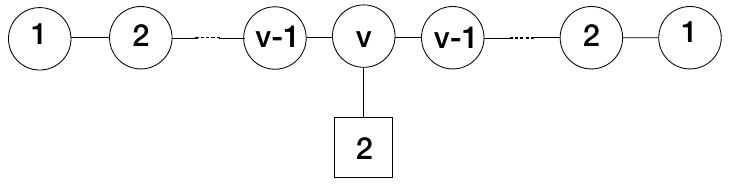
Figure 7 . The Kronheimer-Nakajima quiver associated to a ’t Hooft loop labelled by B = ( p; 0) ( with p even) in the sector v = ( p= 2 ; p= 2) in an N = 2 (cid:3) U(2)